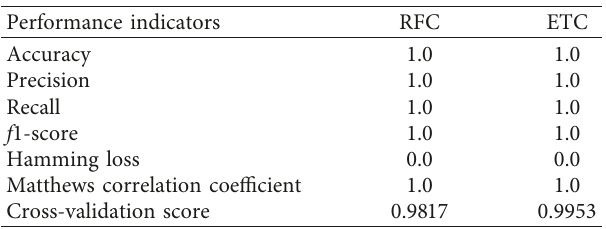
Table 8: Cross-validation score and the six performance metrics of both RFC ETC.